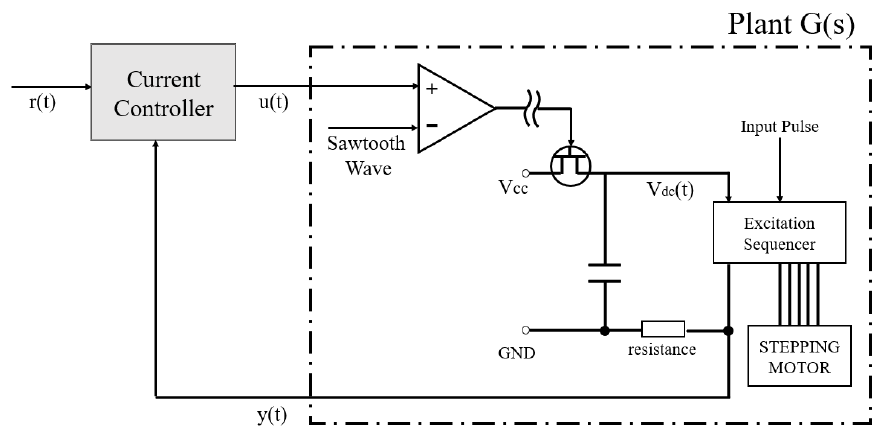
Figure 2. The plant diagram of the constant current control